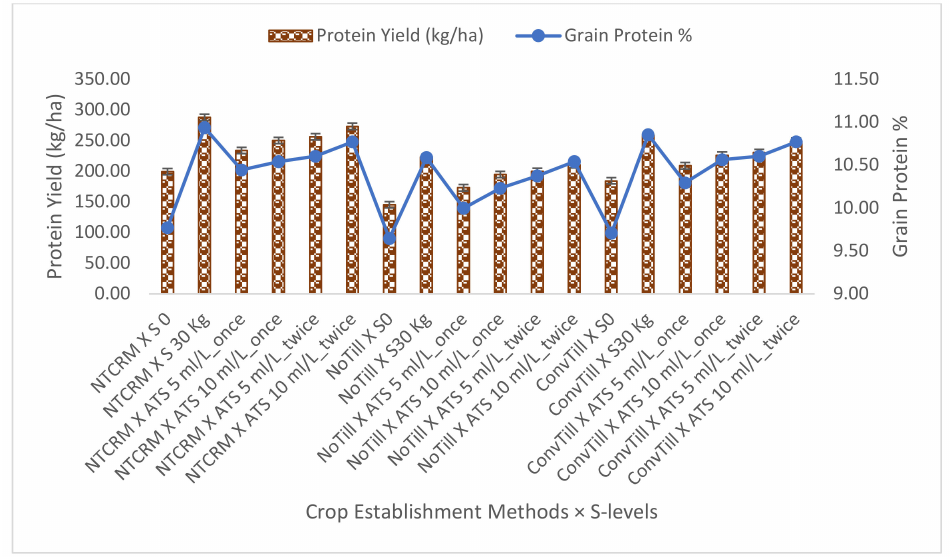
Figure 1. Grain protein content (%) and grain protein yield (kg/ha) of pearl millet as influenced by crop establishment methods and sulphur management strategies (mean of two years of